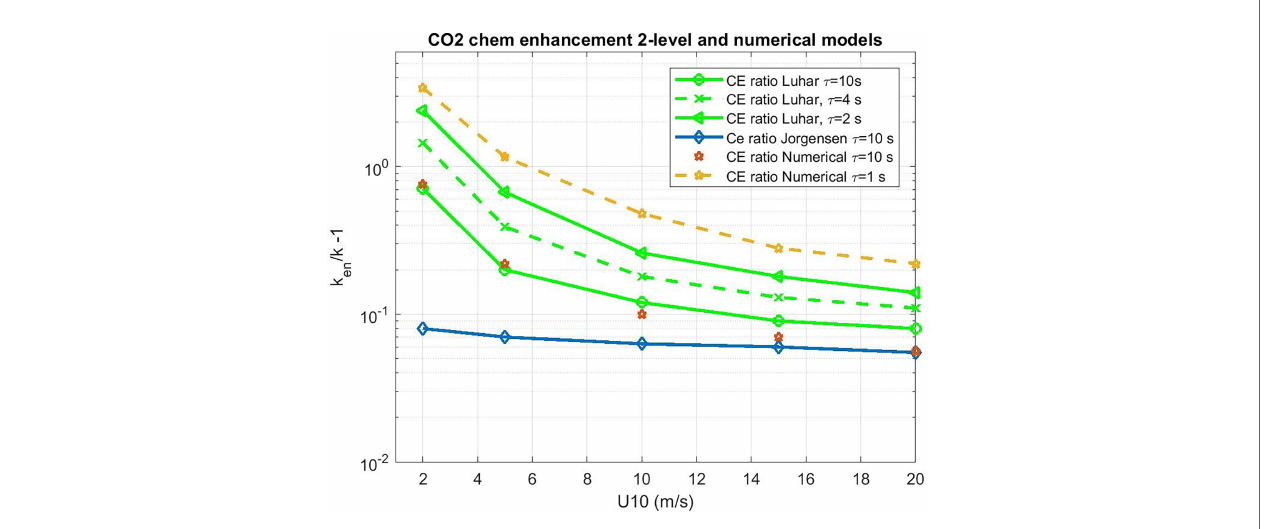
FIGURE 4 | Water side transfer velocity (normalized to Sc = 660) ratio of chemical enhanced to background value as a function of 10-m wind speed. Estimates of chemical enhancement (CE) via (42) for CO 2 are shown with star symbols using a numerical integration of (34) and (19) and the analytical model (38) as green lines for different values of the CO 2 carbonate reaction time constant, t r . The results of the Jørgensen et al. (2020) are shown as